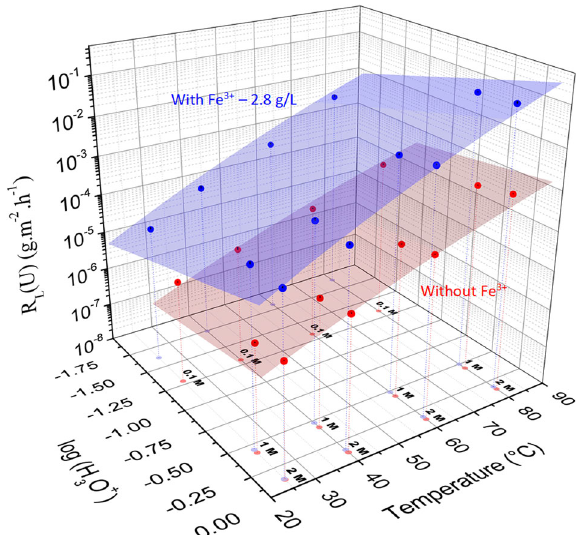
Fig. 7 Experimental and simulated dissolution rates of branner- ite. Simulated maps obtained by fi tting the multiparametric expression of the normalized dissolution rate of synthetic brannerite samples based on the data obtained without (red dots) or with (blue dots) Fe(III) in sulfuric acid solutions.